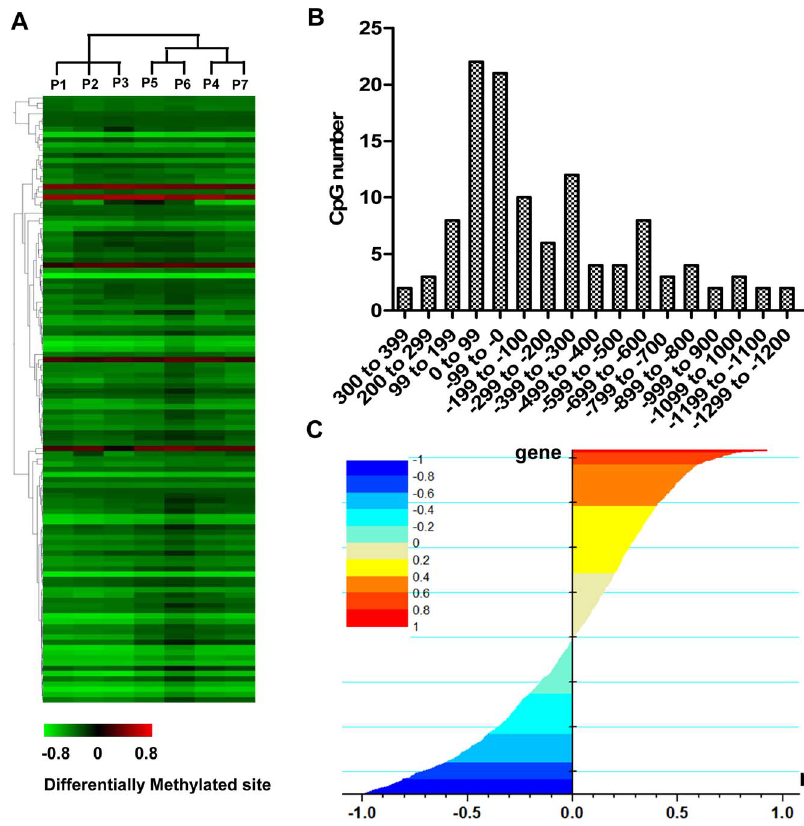
Figure 1. The characteristics of genome-wide DNA methylation in atherosclerosis. ( A ) The hierarchical cluster analysis of differentially methylated sites in atherosclerosis. The fold changes of DNA methylation compared to control sample pools were indicated by the color bar. P1–P7 indicated the 7 atherosclerosis sample pools. ( B ) Distribution analysis of the distance of differentially methylated sites to the transcription start site (TSS). The x-axis represented different distance ranges of differentially methylated sites to the corresponding TSS. ( C ) Pearson correlation coefficient of the fold changes of mRNA expression and the Db of corresponding DNA methylation. The x-axis represented the Pearson correlation coefficient (r). The color bar showed the different ranges of Pearson correlation coefficient.